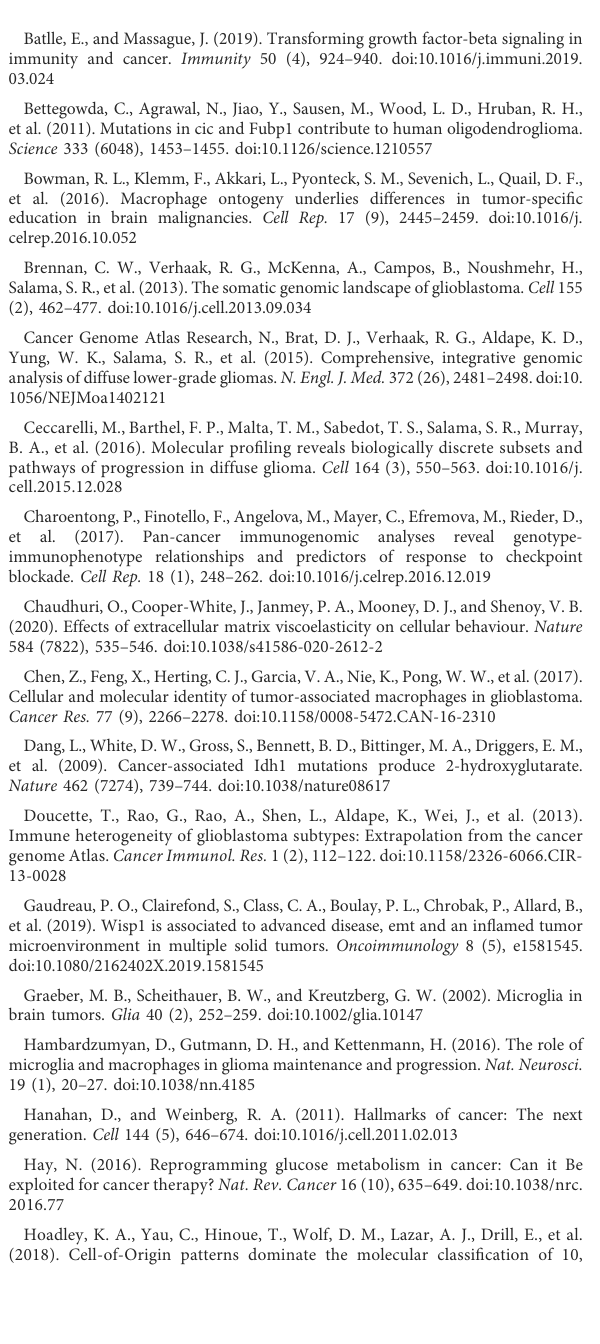
SUPPLEMENTARY FIGURE S4 Receptors and Interacting Proteins of CCN family. (A) Single cell sequencing analysis of correlation between CCN4 and immune stromal cells and malignant cells. (B) Protein-protein interaction networks of CCN family genes were constructed using the STRING database. (C) Correlation of CCN family and CCNscore with integrins. * p < 0.05, ** p < 0.01, and *** p < 0.001. SUPPLEMENTARY FIGURE S5 Functions of CCN family. (A) Correlation of CCN family and CCNscore with tumor hallmarks. (B,C) KEGG (B) and GO (C) analysis of the CCNScore high and low subgroups indicated the main functions and pathways of CCN family.Thebarplotwasorderbyqvalue.* p < 0.05,** p < 0.01,and*** p <